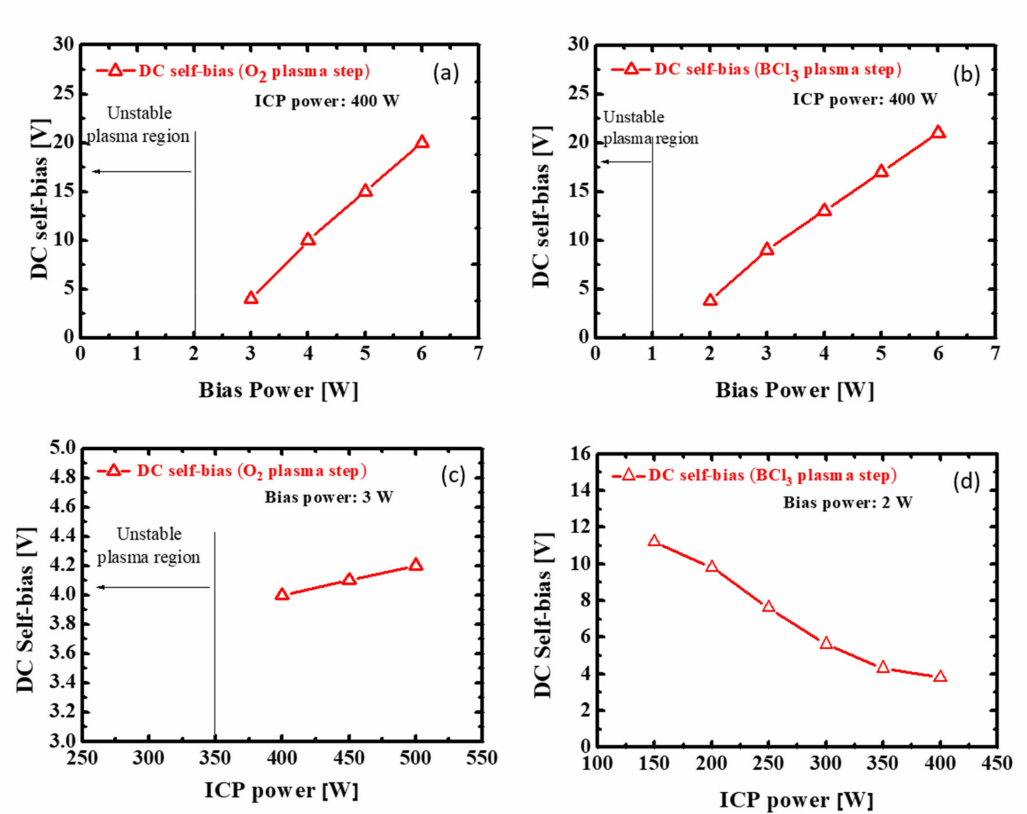
Figure 2. DC self-bias under varying bias powers at the ( a ) O 2 and ( b ) BCl 3 plasma steps, and under varying ICP powers at the ( c ) O 2 and ( d ) BCl 3 plasma steps.